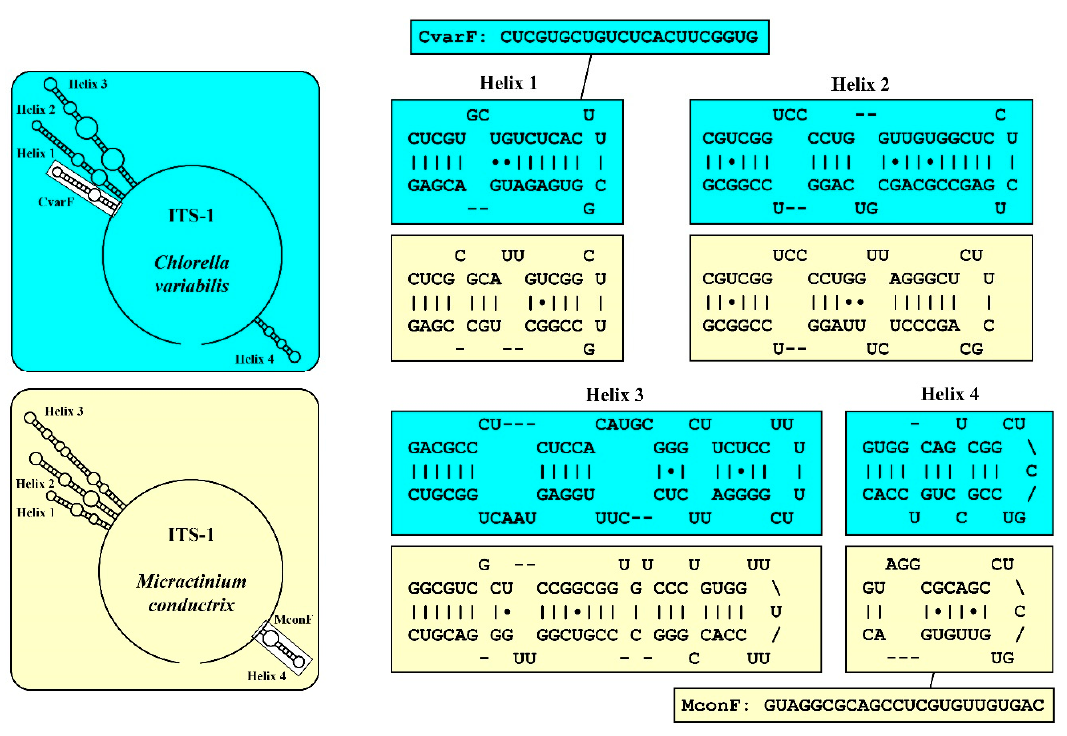
Figure 3. ITS-1 secondary structure of Chlorella variabilis (blue) and Micractinium conductrix (yellow). The positions of the diagnostic primers CvarF and MconF are highlighted in white boxes in the structures.